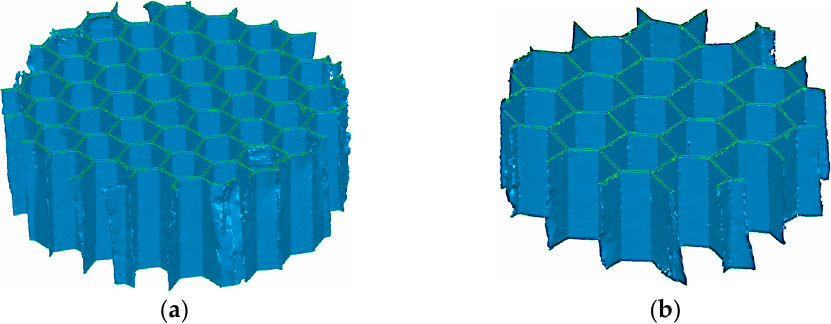
Figure 5. CT models of two of the studied materials: ( a ) 1/8-0.0015 and ( b ) 3/16-0.0015. Analyzing the actual structures of the cores via the creation of three-dimensional models using computed tomography allowed for the examination of the basic geometric parameters, e.g., the length of individual walls, the size of the cell, and the bending radii of the walls near the joints. Exemplary measurement results are shown in Figure 6.